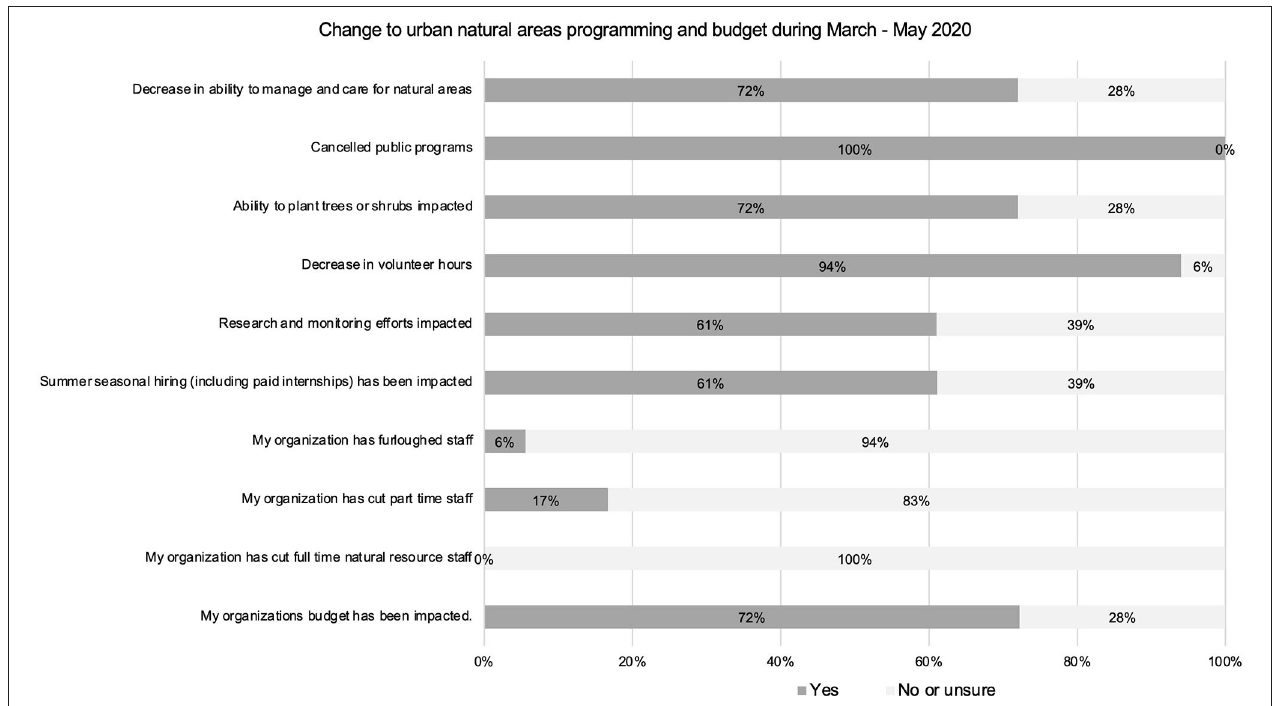
FIGURE 2 | Observed changes in programming and funding in urban natural areas management in 12U.S. cities during the COVID-19 in March to May